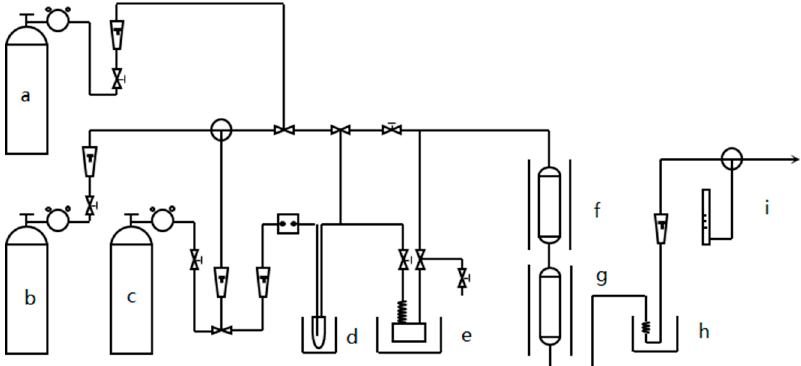
Figure 2. System of laboratory SWGS test: ( a ) N 2 for catalyst stabilization ( b ) Dry gas; ( c ) N 2 ; ( d ) evaporator 1; ( e ) evaporator 2; ( f ) reactor 1; ( g ) reactor 2; ( h ) gas-liquid separator; ( i ) outlet to GC.